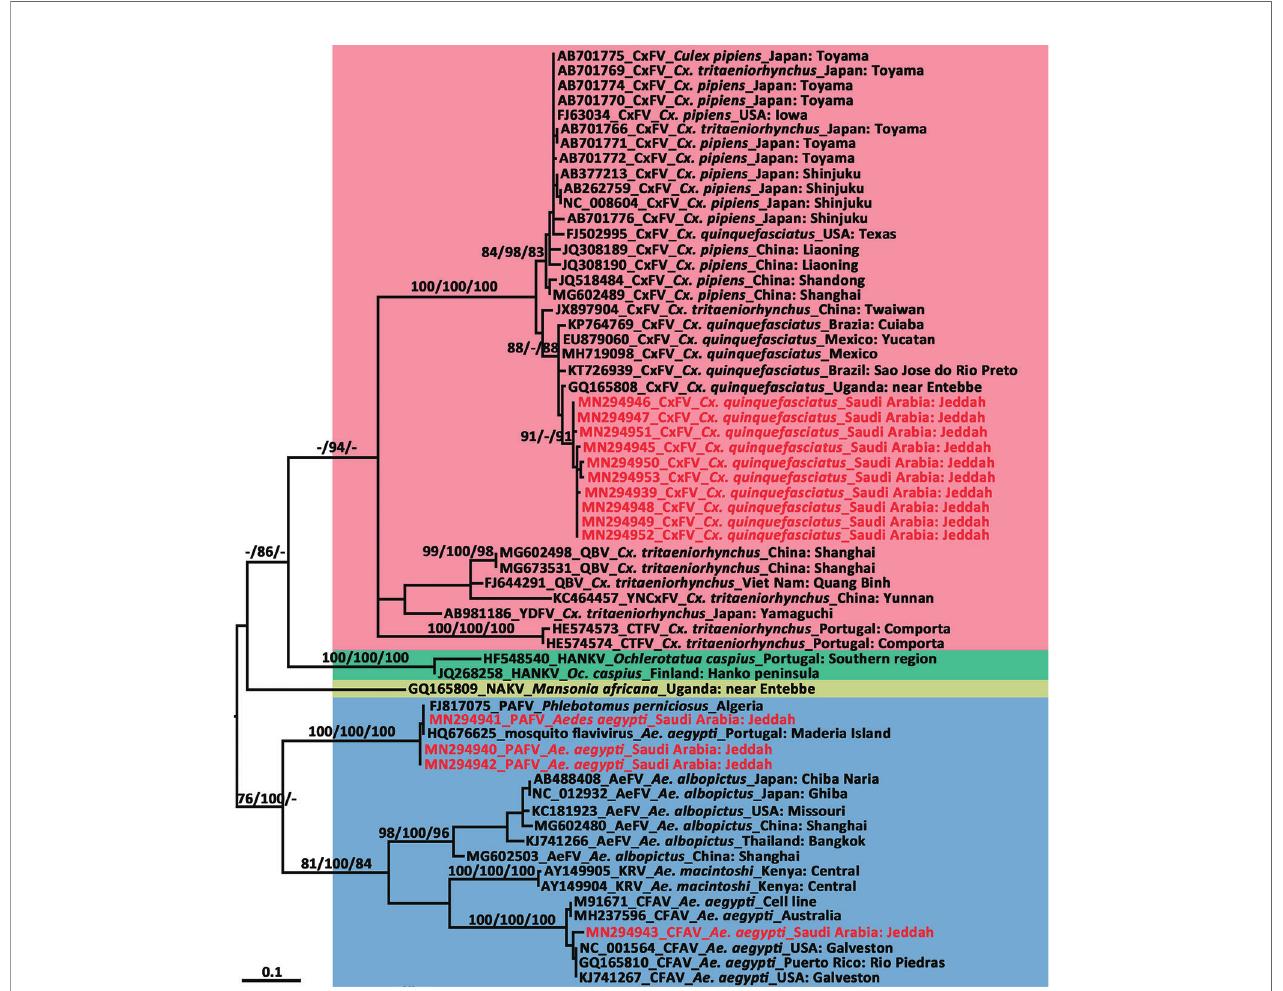
FIGURE 6 | Phylogenetic tree generated by maximum likelihood analysis of insect-speci fi c fl avivirus (ISFV) partial non-structural 5 gene. Sequences referable to the same host-genus (except for the Phlebotomus-associated fl avivirus) are shown with the same colors in the tree. The ISFV sequences obtained in this study are marked in red. Bootstrap values (1,000 replicates, not shown for less than 75%) of maximum likelihood; Bayesian analyses and neighbor-joining are shown above the main lineages. The bar indicates 0.1 substitutions per site. AEFV, Aedes fl avivirus; CFAV, cell fusing agent virus; CTFV, Culex theileri fl avivirus; CxFV, Culex fl avivirus; HANKV, Hanko virus; KRV, Kamiti River virus; NAKV, Nakiwogo virus; PAFV, Phlebotomus-associated fl avivirus; QBV, Quang Binh virus; SCxFV, Spanish Culex fl avivirus; YDFV, Yamadai fl avivirus; YNCxFV, Yunnan Culex fl avivirus.